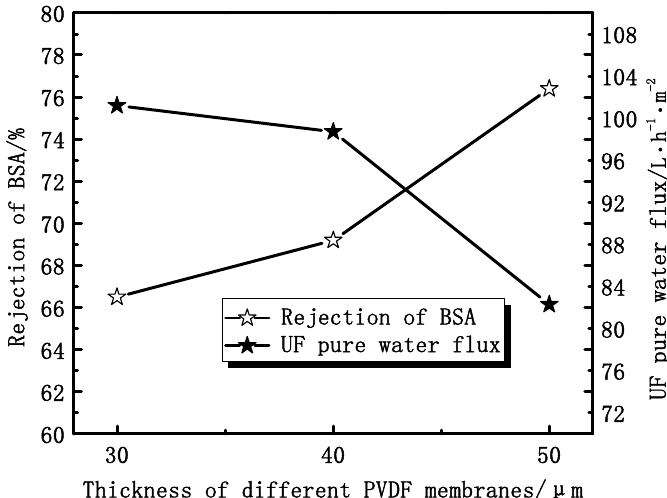
Figure 9. The effect of thickness on the UF flux and the rejection of